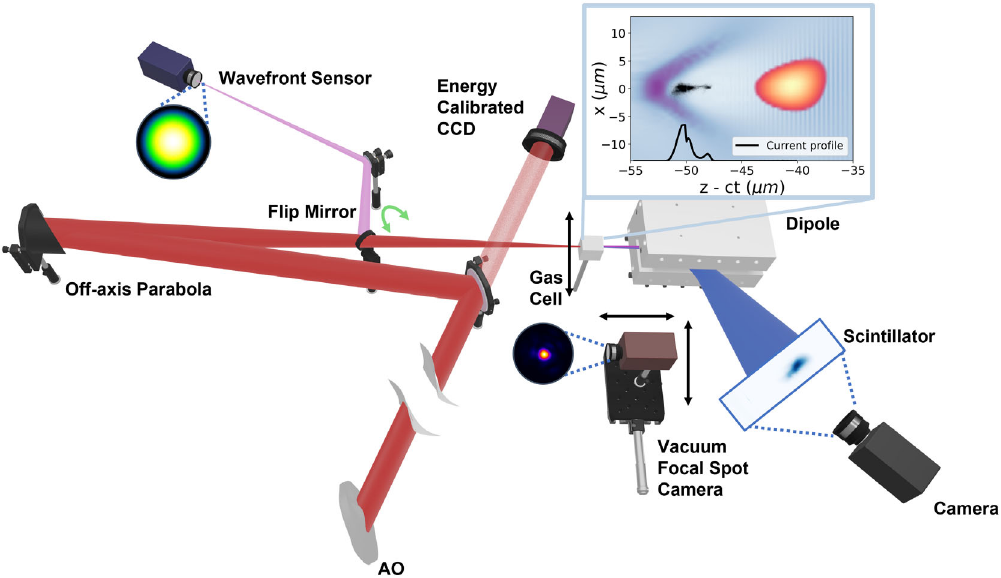
FIG. 1. Experimental setup at the Lund Laser Centre. The laser is focused into the gas cell by the off-axis parabola. The interaction between the laser and the plasma produces an accelerating cavity and electron bunch which is illustrated in the simulated inset. Accelerated electrons exiting the gas cell are then dispersed with the permanent dipole magnet and produce scintillating radiation on a LANEX screen which is then imaged onto a 16-bit CCD. An adaptive optic, set after the compressor, is used to tune the beam wavefront. Laser diagnostics are performed in vacuum using attenuators before the compressor: using the flip mirror, the beam (in pink) can be extracted to measure wavefront curvature using a Phasics wavefront sensor; the energy distribution in the focal volume is recorded in vacuum using a camera movable on axis in place of the gas cell. The adaptive optic settings are altered to produce the three laser setting cases displayed in Fig. 2 as measured by the focal spot camera under vacuum. Energy measurements are taken using the leak beam (shown in light red) through a dielectric mirror and a calorimeter-calibrated camera.